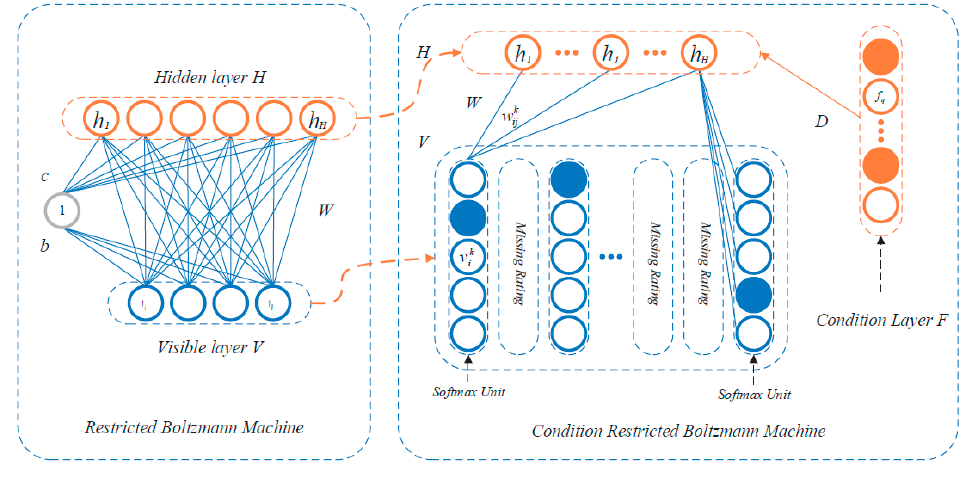
Figure 5. Restricted Boltzmann machine [73].